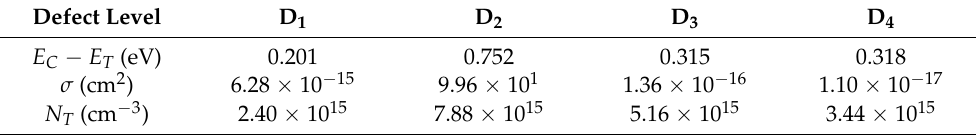
Figure 3. ( a ) Dependence of the Fourier-transform deep-level transient spectroscopy (FT-DLTS) signals on T W measured under V r = − 0.1 V, V P =1 V, and t P = 50 ms. ( b ) Arrhenius plots of FT-DLTS signals for D 1 , D 2 , D 3 , and D 4 . Table 2. Defect parameters in the InGaAs channel determined from FT-DLTS measurements.